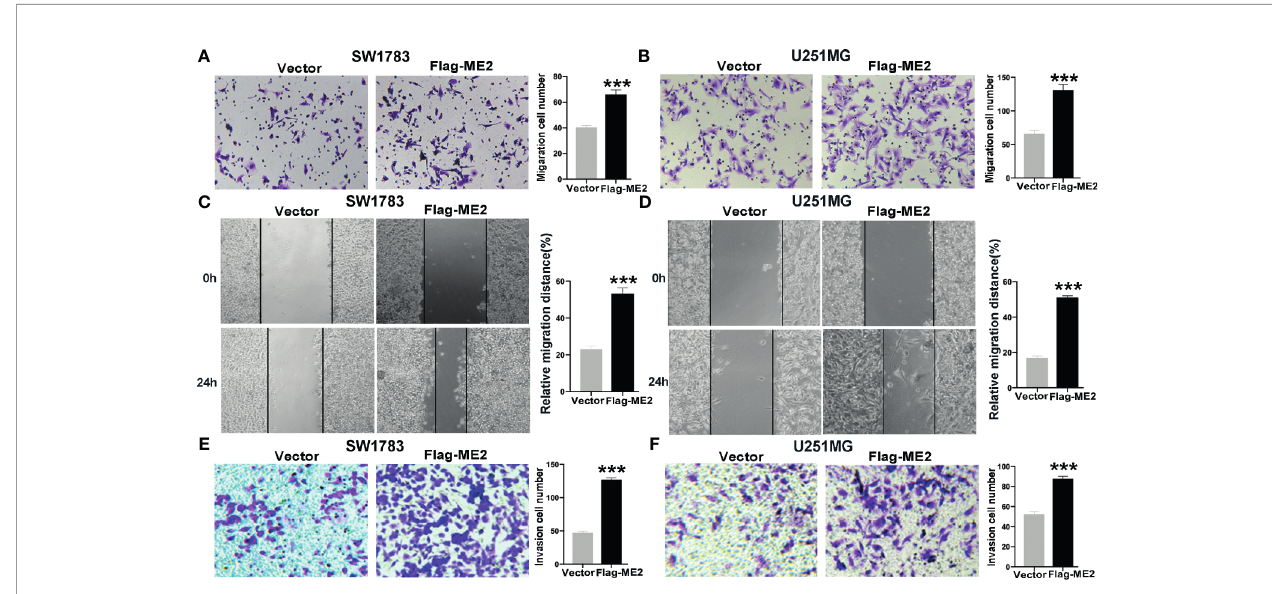
FIGURE 5 | Overexpression of ME2 promotes migration and invasion of GBM cells. (A) Representative images of the migration of SW1783 cells transfected with vector or Flag-ME2 plasmids (***P < 0.0001). (B) Numbers of migrated cells after Flag-ME2 transfection in U251MG cells (***P < 0.0001). (C, D) Wound healing assays to evaluate the effects of ME2 on migratory ability of SW1783 (C) and U251MG (D) cells (***P < 0.0001). (E, F) Invasion ability of SW1783 (E) and U251MG (F) cells transfected with vector or Flag-ME2 plasmids determined by transwell invasion assay (***P <